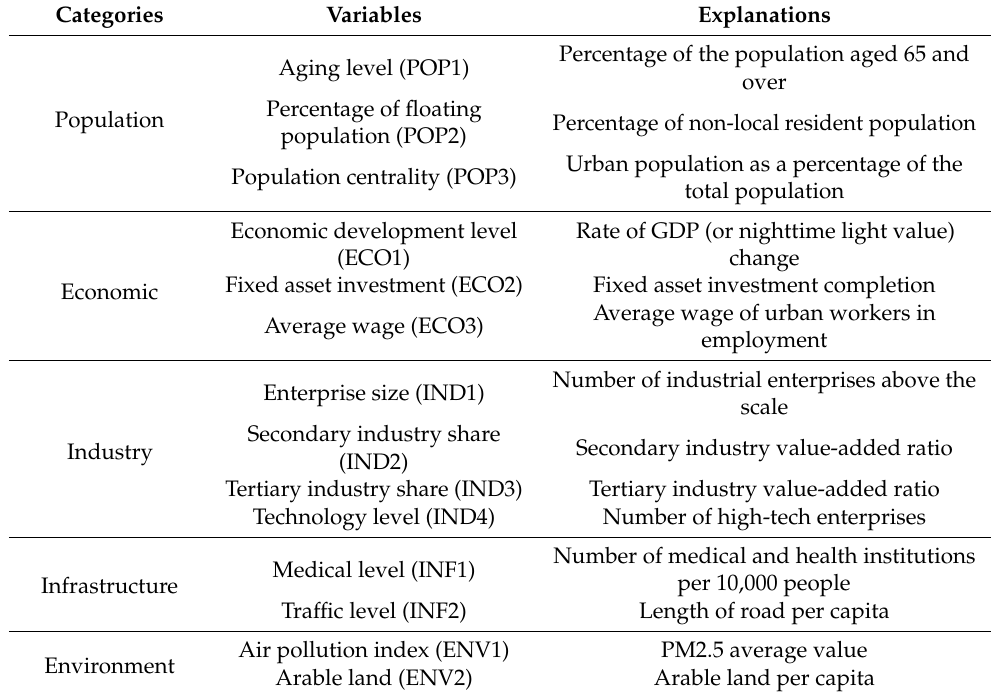
Table 1. Factors influencing the shrinkage of cities and